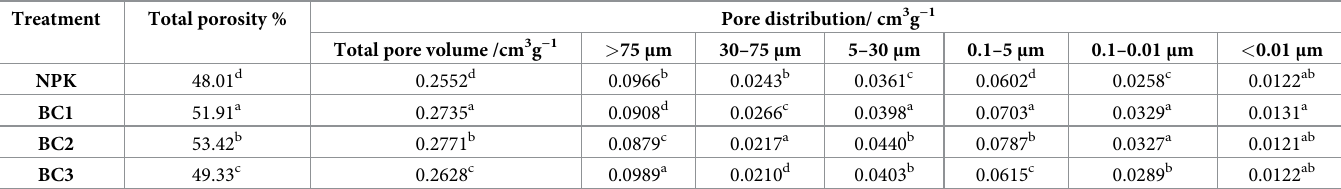
Table 3. Total porosity and pore-size distribution of biochar-treated soils after a 3-year treatment period. Treatment